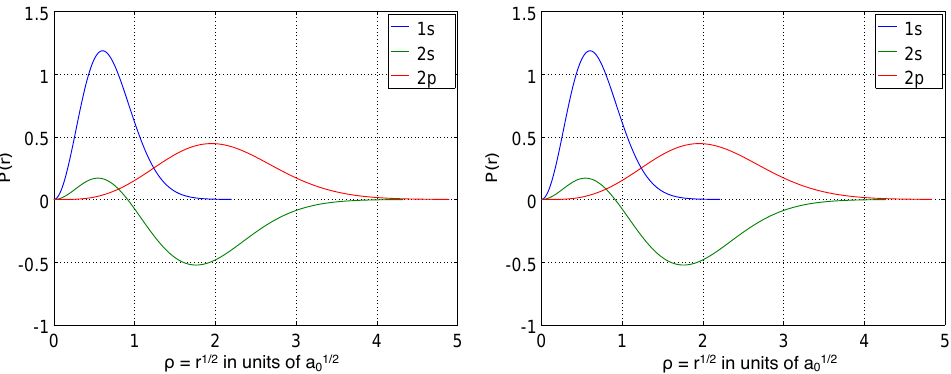
Figure 4. Left : plot of the large components of the 1 s , 2 s and 2 p 3/2 orbitals in Li I as functions of √ r , where r is in units of the Bohr radius a 0 . Right : large components from converted MCHF ρ = orbitals.